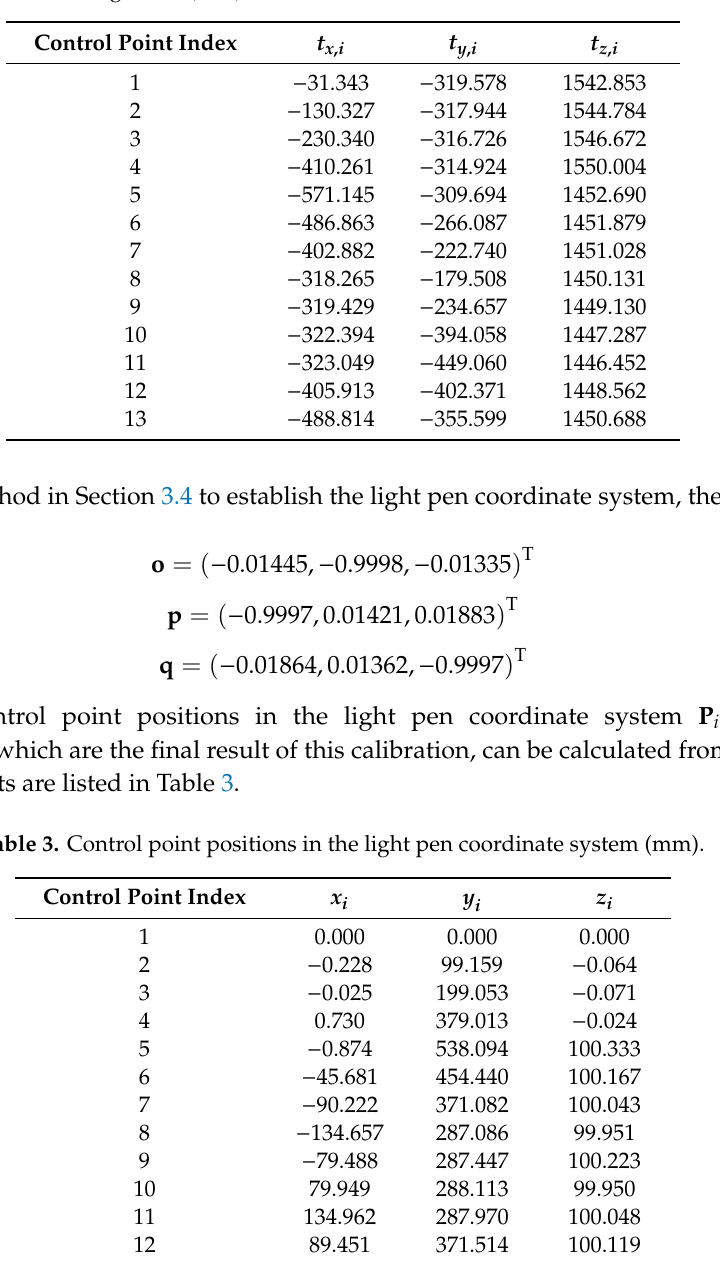
Table 2. Translation vectors between control point coordinate systems and the camera coordinate system at the position in Figure 4a (mm).